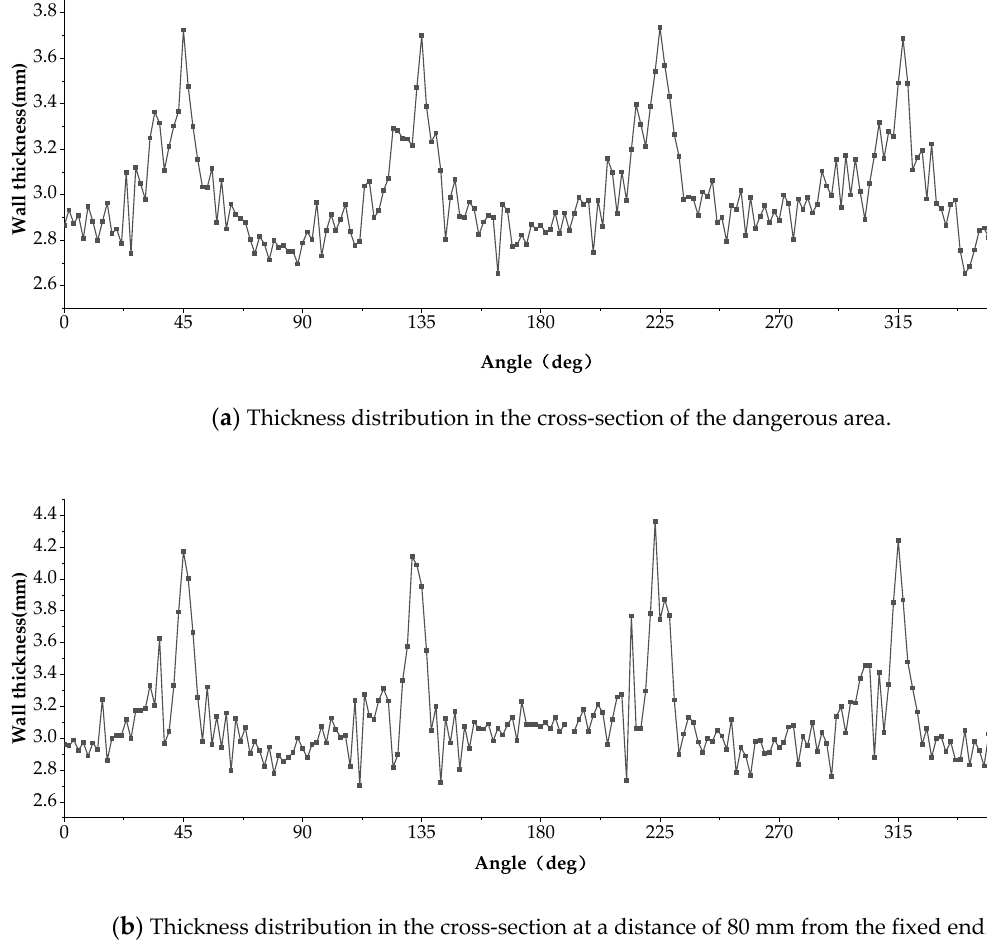
Figure 10. Thickness distribution in a typical cross-section of a workpiece.